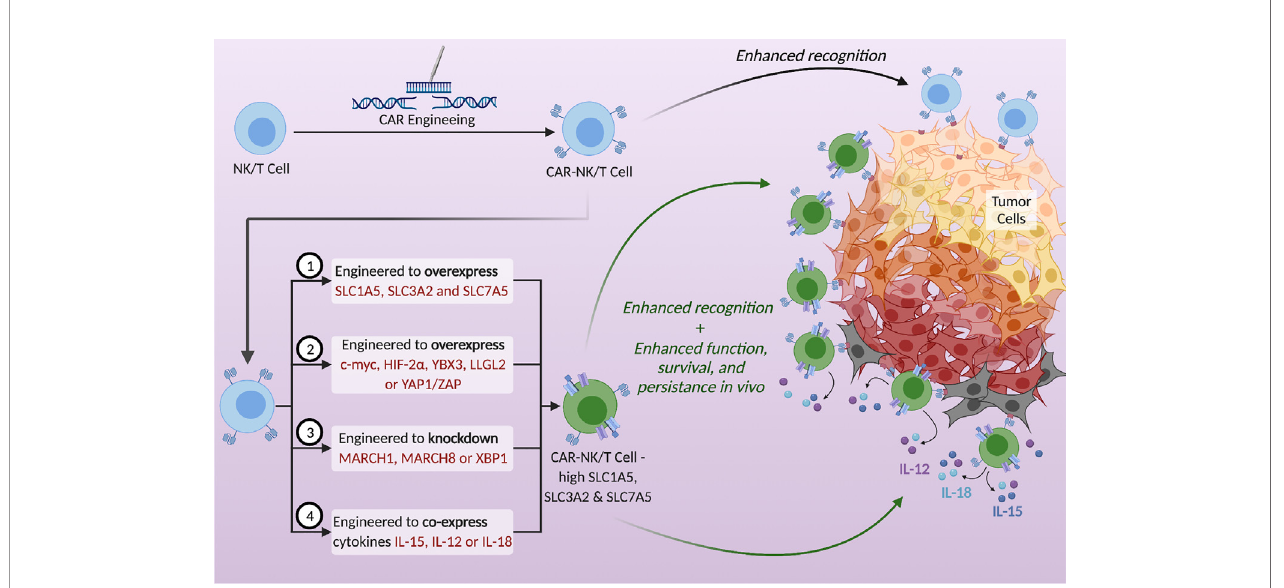
FIGURE 2 | Potential strategies to utilize SLC1A5, SLC3A2, and SLC7A5 to enhance the metabolic fi tness of NK and T cells and thereby strengthen anti-tumor immunotherapy. CAR-NK/T cells exhibit enhanced tumor recognition but are often metabolically disadvantaged in the TME. Upregulation of the SLC transporters in CAR-NK/T cells using the proposed tactics could enhance their function, survival, and persistence in vivo . Possible strategies are (1) to genetically engineer CAR- NK/T cells to overexpress these transporters, (2) to overexpress speci fi c proteins that increase the expression of SLCs, (3) to knockdown genes that decrease the expression of SLCs, and (4) to engineer CAR-NK/T cells to co-express cytokines, speci fi cally IL-15, IL-12, or